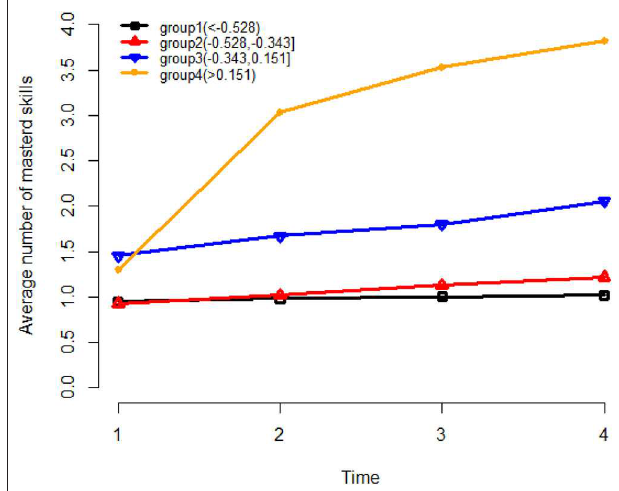
FIGURE 12 | The average number of mastered skills at each time point for four learning ability groups. − 0.528, − 0.343, and 0.151 are the 1st, 2nd, and 3rd quartile of θ values.